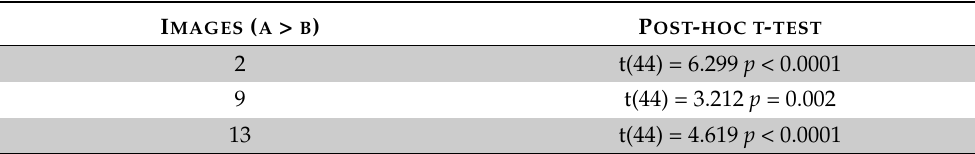
Table 3. Post-hoc t-tests for images with different dynamicity, bodiless heads (A) more dynamic than headless bodies